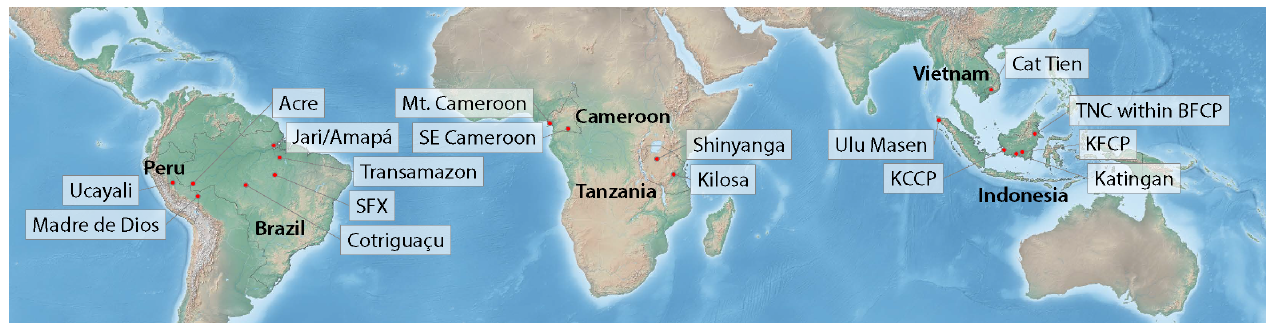
Fig. 1 . Study sites (map credit: Astrid